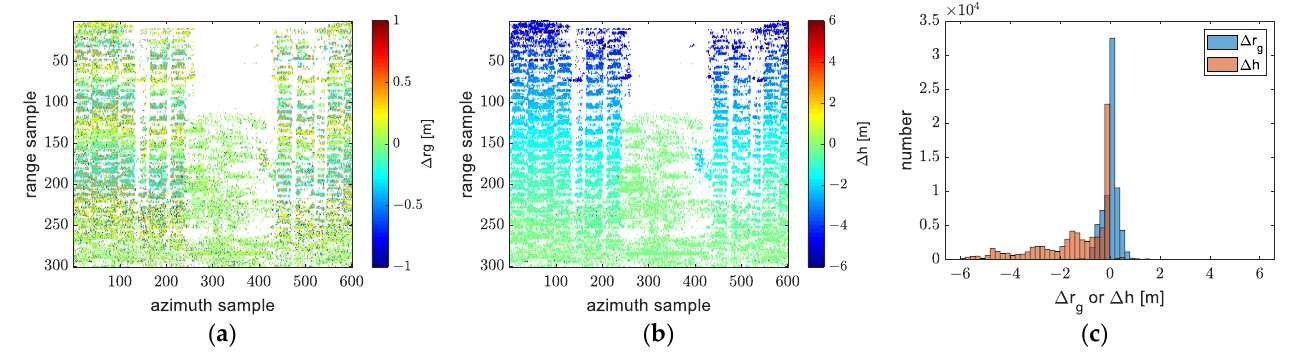
Figure 29. The ground range and height error between model 4 and model 5: ( a ) the ground range error; ( b ) the height error; ( c ) a histogram of the ground range and height error.